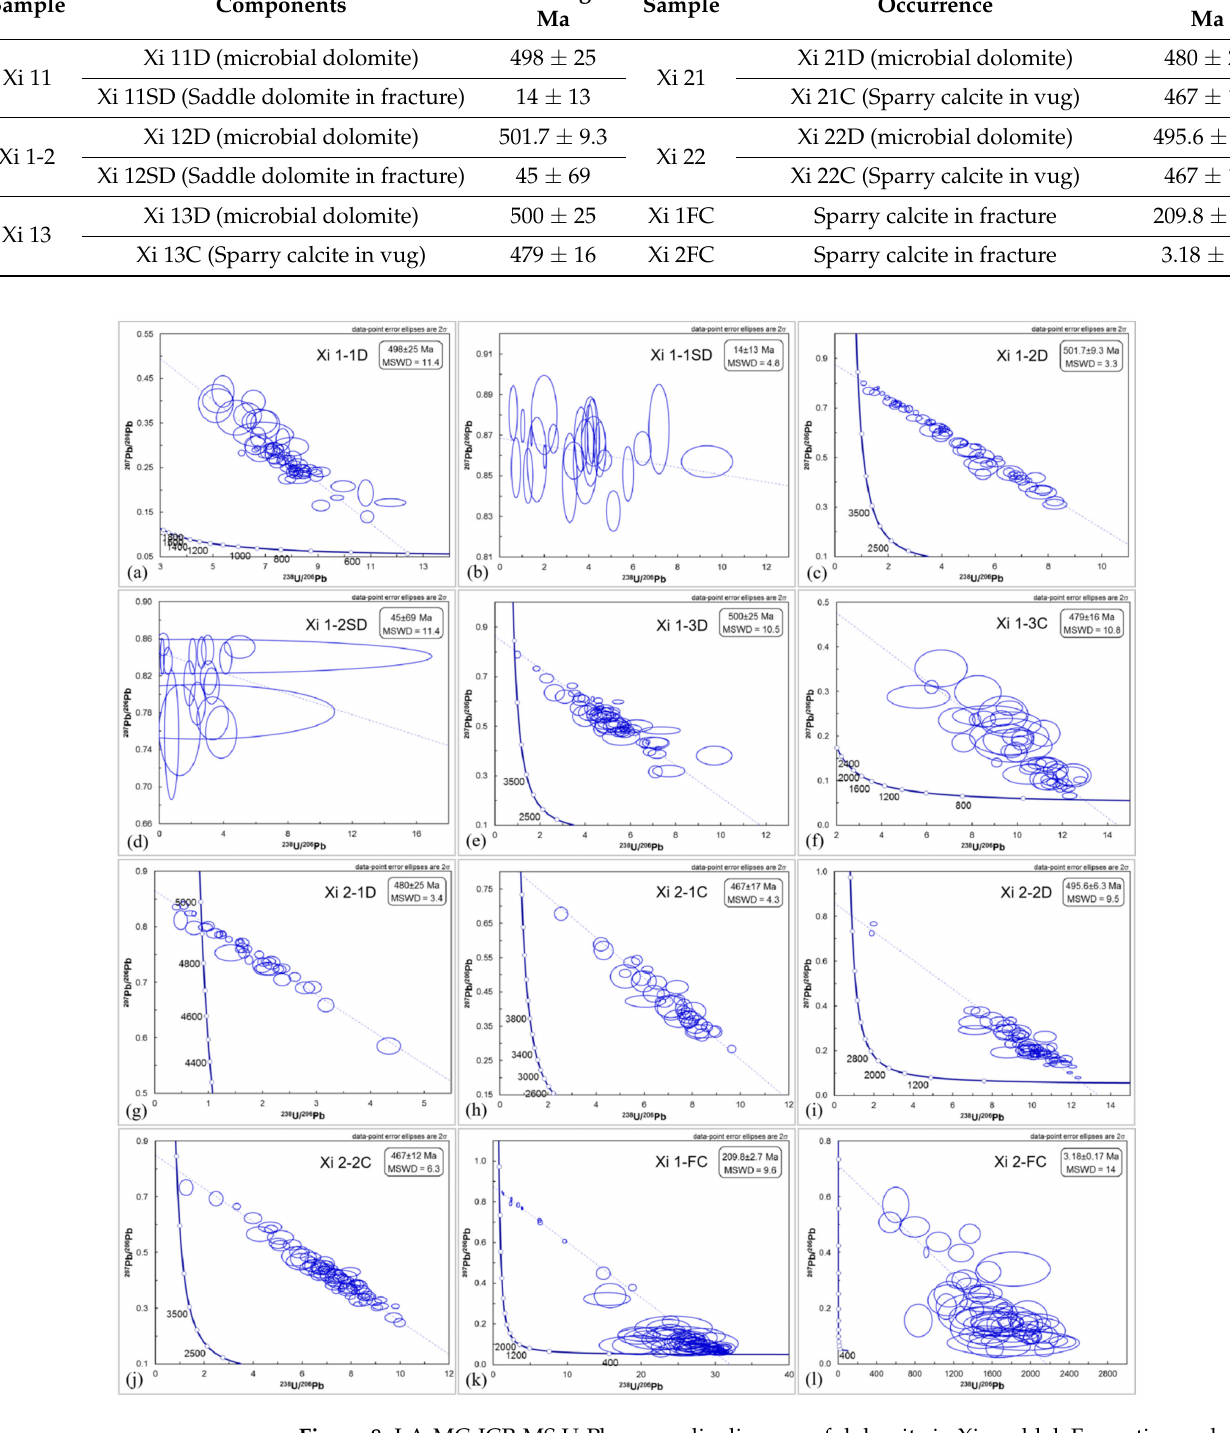
Figure 8. LA-MC-ICP-MS U-Pb concordia diagram of dolomite in Xiaoerblak Formation carbonate: ( a ) Microbial dolomite of sample Xi 1-1; ( b ) Saddle dolomite of sample Xi 1-1; ( c ) Microbial